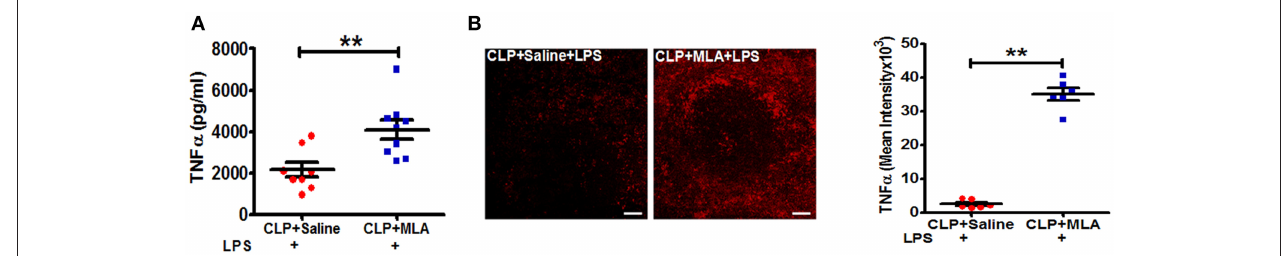
FIGURE 4 | Methyllycaconitine treatment restores LPS-induced TNF α responses in CLP-survivors. BALB/c mice were subjected to control and CLP surgery, allowed to recover for 4 weeks, and then treated by intraperitoneal injection with methylcaconitine (MLA; 4 mg/kg) or vehicle (saline) 30min prior to LPS-challenge (4 mg/kg). Blood and spleens were harvested 90min after LPS administration. Serum TNF α was measured by ELISA. (A) Enhanced LPS-induced serum levels of TNF α in endotoxemic MLA-treated CLP-surviving mice. Results represent the mean ± SEM of 6–9 mice per group from two independent experiments; CLP + Saline + LPS vs. CLP + MLA + LPS ** p < 0.01. (Mann-Whitney U -test). (B) TNF α staining in spleen sections of CLP + Saline + LPS and CLP + MLA + LPS. Magnification (20X; scale bar = 50 µ m). Images are representative of spleen sections from two independent experiments ( n = 6). CLP + Saline + LPS vs. CLP + MLA + LPS ** p < 0.01. (Mann-Whitney U -test).